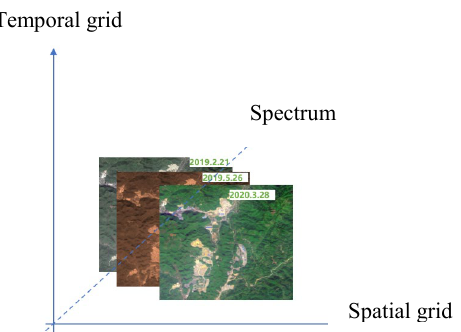
Figure 3 . The new data management model